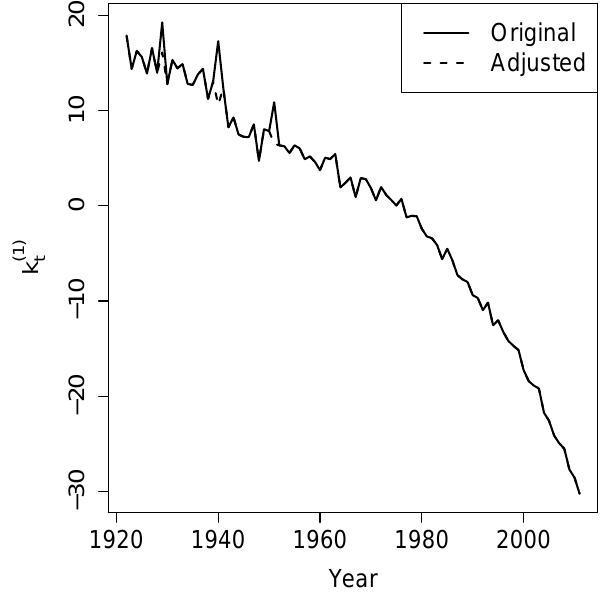
( 1 ) Figure 2. k series with additive outliers t